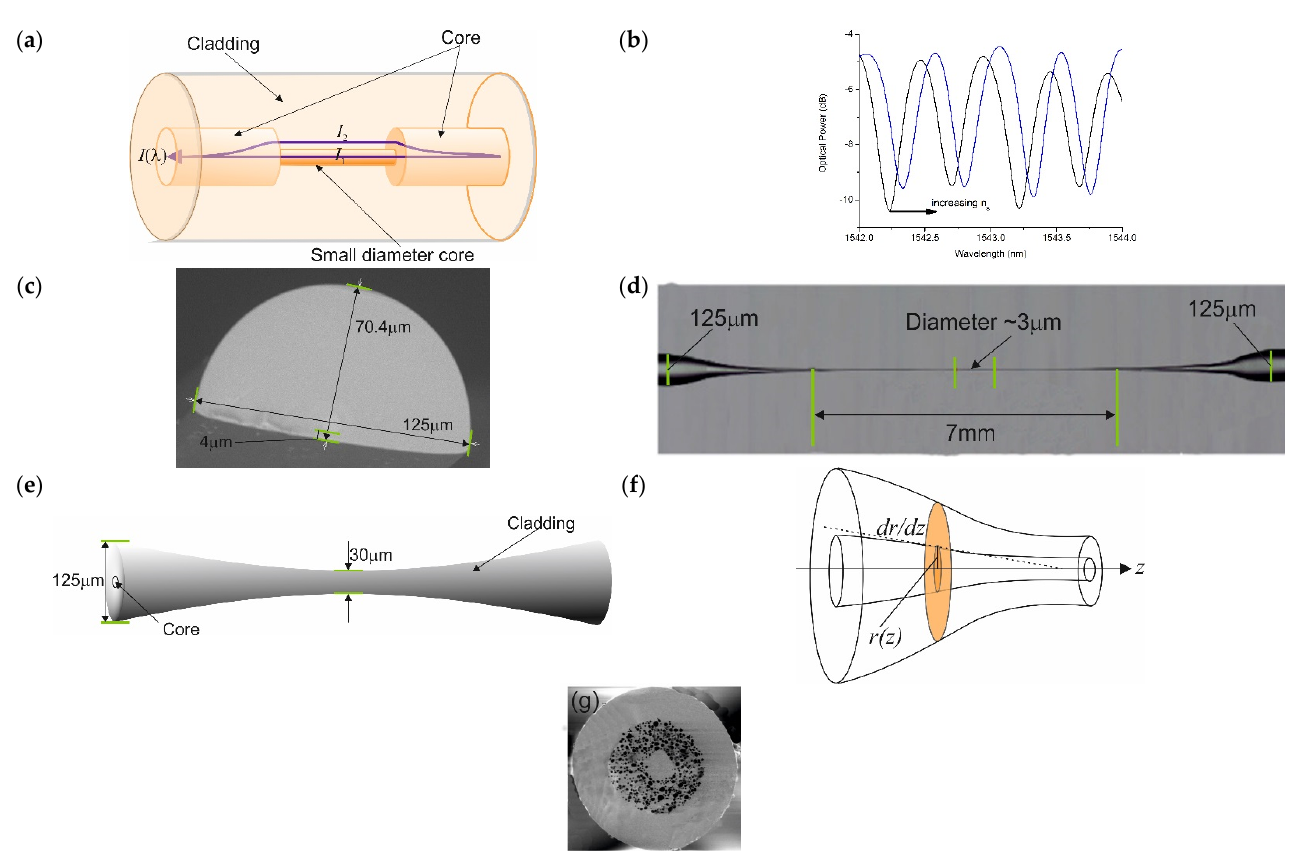
Figure 3. Different types of evanescent field optical fibre sensors. ( a ) Schematic of an in-fiber Mach-Zehnders using a section of smaller-diameter core fusion spliced into an optical fibre. ( b ) A typical transmission spectrum for an in-fiber Mach-Zehnders and its spectral response to a change in the surrounding environments refractive index. ( c ) An image of a section of D-shaped optical fibre with the core/cladding interface to the flat part of the D is 4 µ m. ( d ) A side view image of biconical tapered optical fibre with a central section of nano/micro fibre, with a diameter of 3 µ m. ( e ) Schematic of typical biconial taper with a central waist of 30 µ m. ( f ) A taper showing the parameters of interest to determine spectral behaviour. ( g ) An image of a cross-section of a random-hole optical